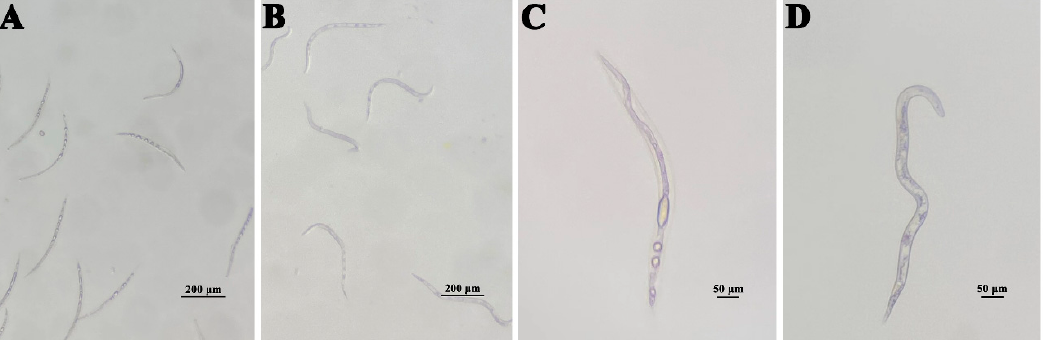
Figure 6. The shapes of active and dead nematodes. ( A , C ) M. incognita treated with compound 4 . ( B , D ) M. incognita treated in methanol blank control.